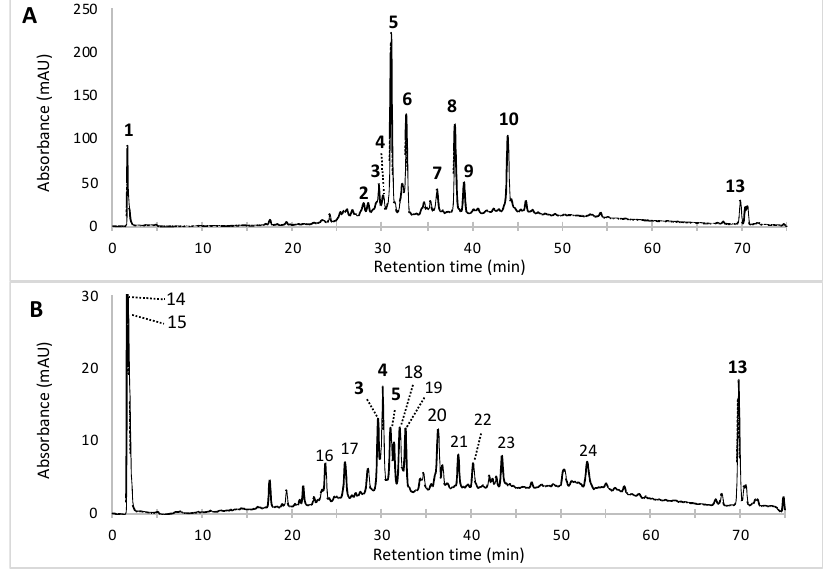
Figure 7. Chromatograms of the overall compounds detected by HPLC-DAD in the samples obtained by pressurized liquid extraction (PLE) using 50% aqueous ethanol as extraction solvent from the mycelium of the marine-derived Talaromyces sp. 30570 strain cultivated in submerged culture: ( A ) in Potato Dextrose Broth (PDB); and ( B ) in Defined Minimal Dextrose broth (DMD). Assignment of the polyketide-based compounds were done by UV-visible spectra and HRMS according to their mass to charge ratio. See Table 2 for the identification of the molecules.